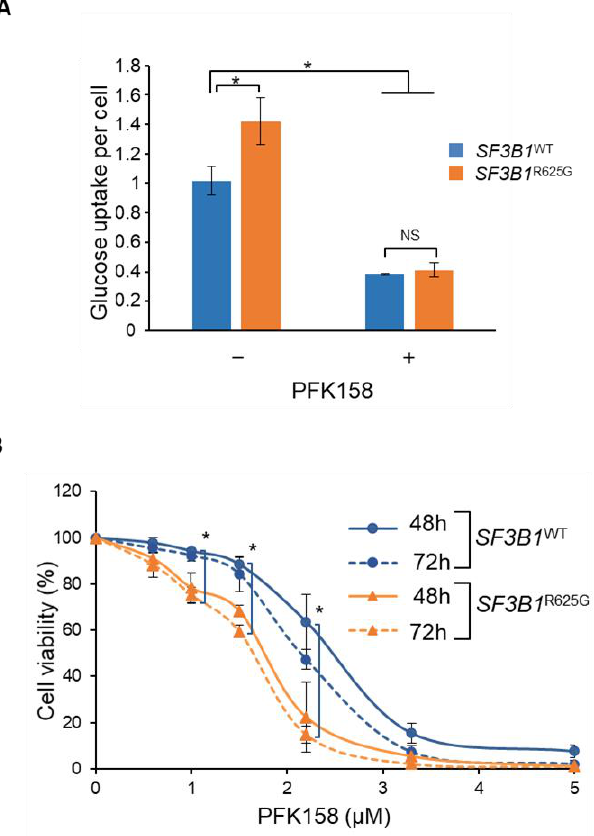
Figure 5. SF3B1 R625G induces an increase of glycolytic rate, thus sensitizing cells to glycolysis inhibition. ( A ) Glucose uptake rate per cell in SF3B1 WT (blue) and SF3B1 R625G (orange) isogenic Mel202 cells with or without PFK158 treatment at 1.6 µ M for 3 days. ( B ) Cell viability of SF3B1 WT (blue) and SF3B1 R625G (orange) Mel202 cells upon treatment with PFK158 at 48 and 72 h. Data are represented as the mean of triplicates ± SD. The Mann–Whitney U test was used to generate the p -values; * p < 0.05; NS: non-significant.